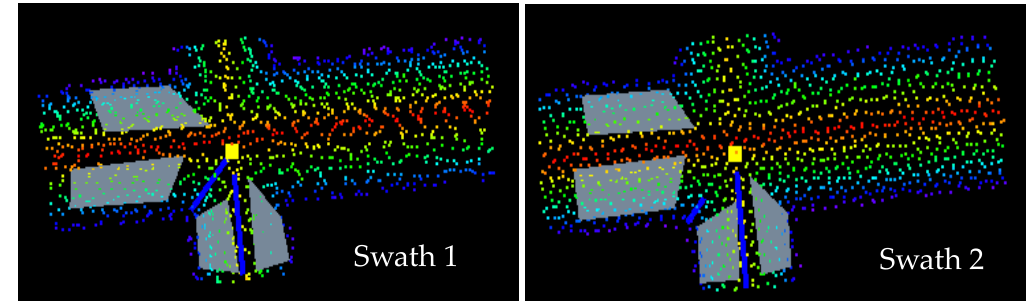
Figure 10. Illustration of interswath consistency.